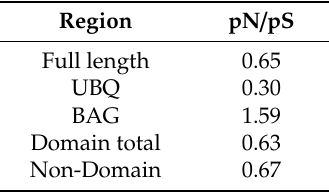
Table 4. Ratios of proportions of nsSNPs and sSNPs within BAG1.